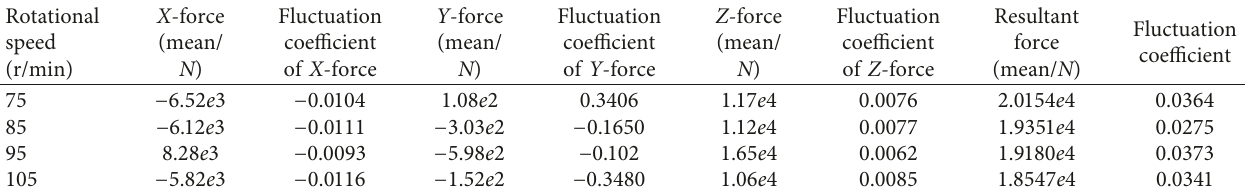
Table 4: The relationship between the rotational speed and the three-directional force of the drum. Rotational